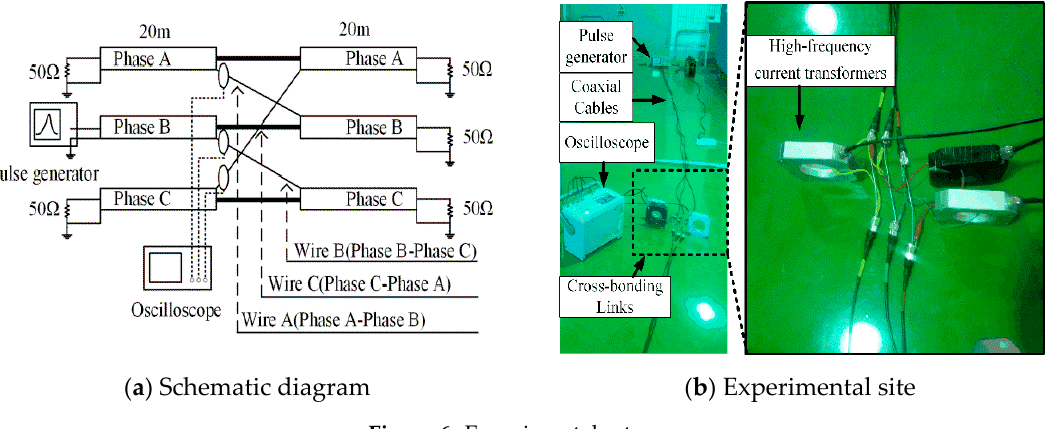
Figure 6. Experimental setup.